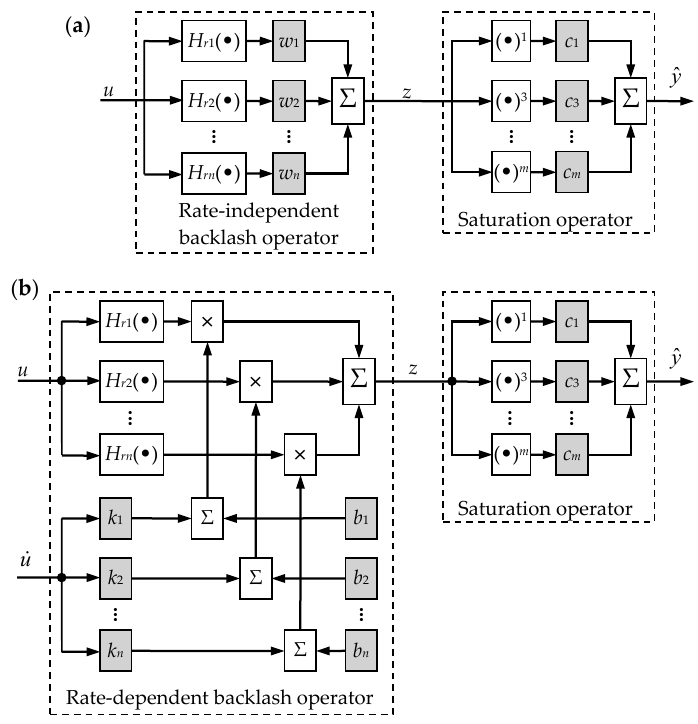
Figure 2. Schematic diagram of the modified Prandtl-Ishlinskii (PI) model: ( a ) rate-independent hysteresis model and ( b ) rate-dependent hysteresis model.